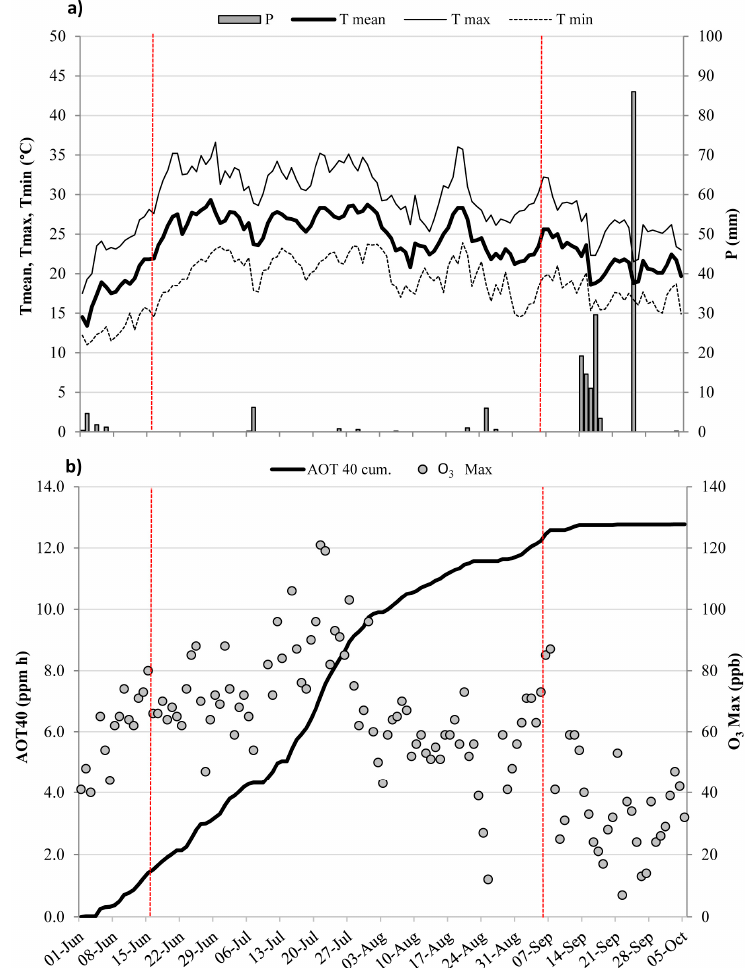
Figure 1. Meteorological conditions and ozone levels during the experimental period (from 1 June to 5 October 2006). ( a ) Daily values of air temperature (mean, Tmean; maximum, Tmax, and minimum, Tmin, °C) and rainfall (P, mm); ( b ) Accumulated exposure Over the Threshold of 40 ppb (AOT40), accumulated over the experimental period (ppm h), and hourly O 3 maximum (ppb) measured during daylight hours. Vertical red bars indicate the extent of the experimental drought period (from 16 June to 8 September).